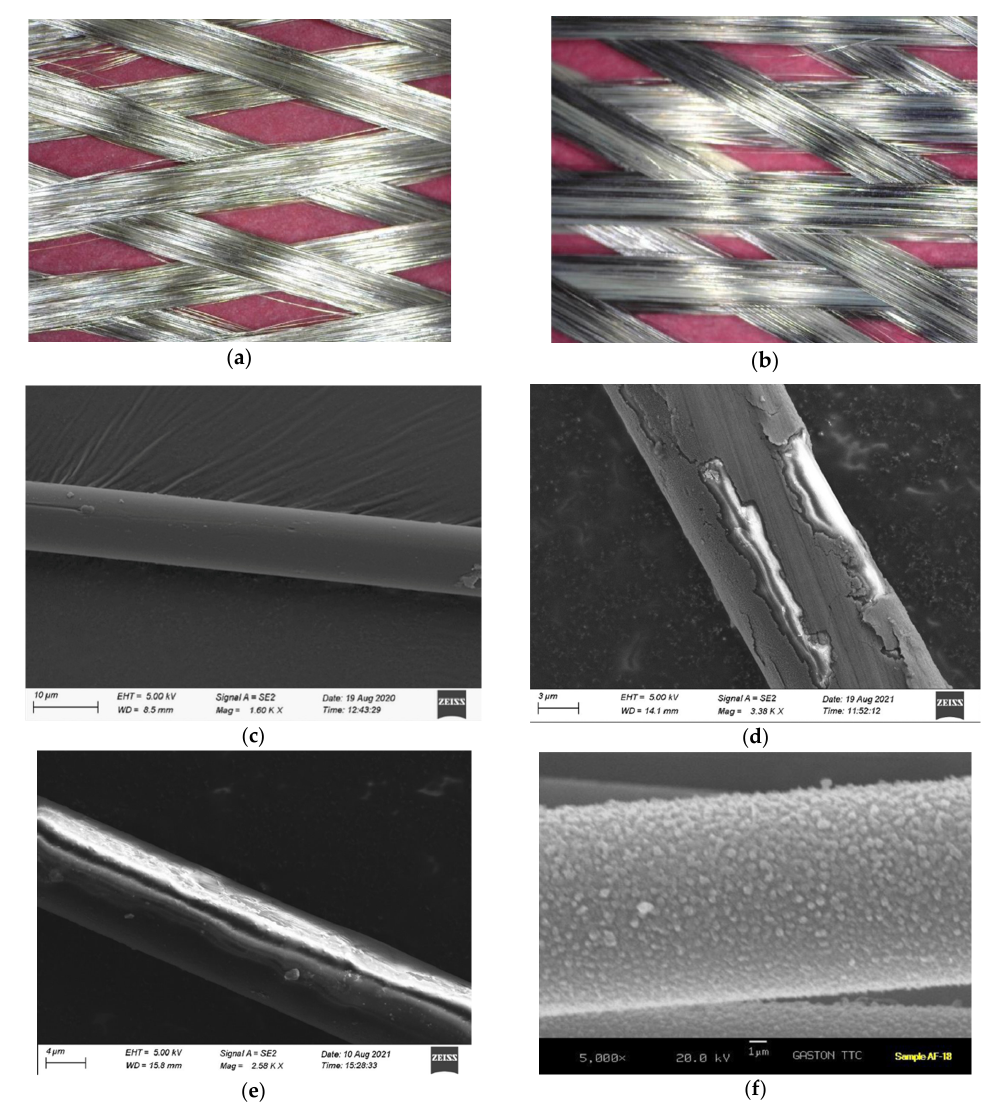
Figure 3. ( a ) Silver ‐ coated yarn ( b ) Aluminum ‐ coated yarn; SEM images of single fibers ( c ) Control ( d ) Aluminum ‐ coated ( e ) Copper ‐ coated ( f ) Al/AlN ‐ coated. ( d ) Aluminum-coated ( e ) Copper-coated ( f )